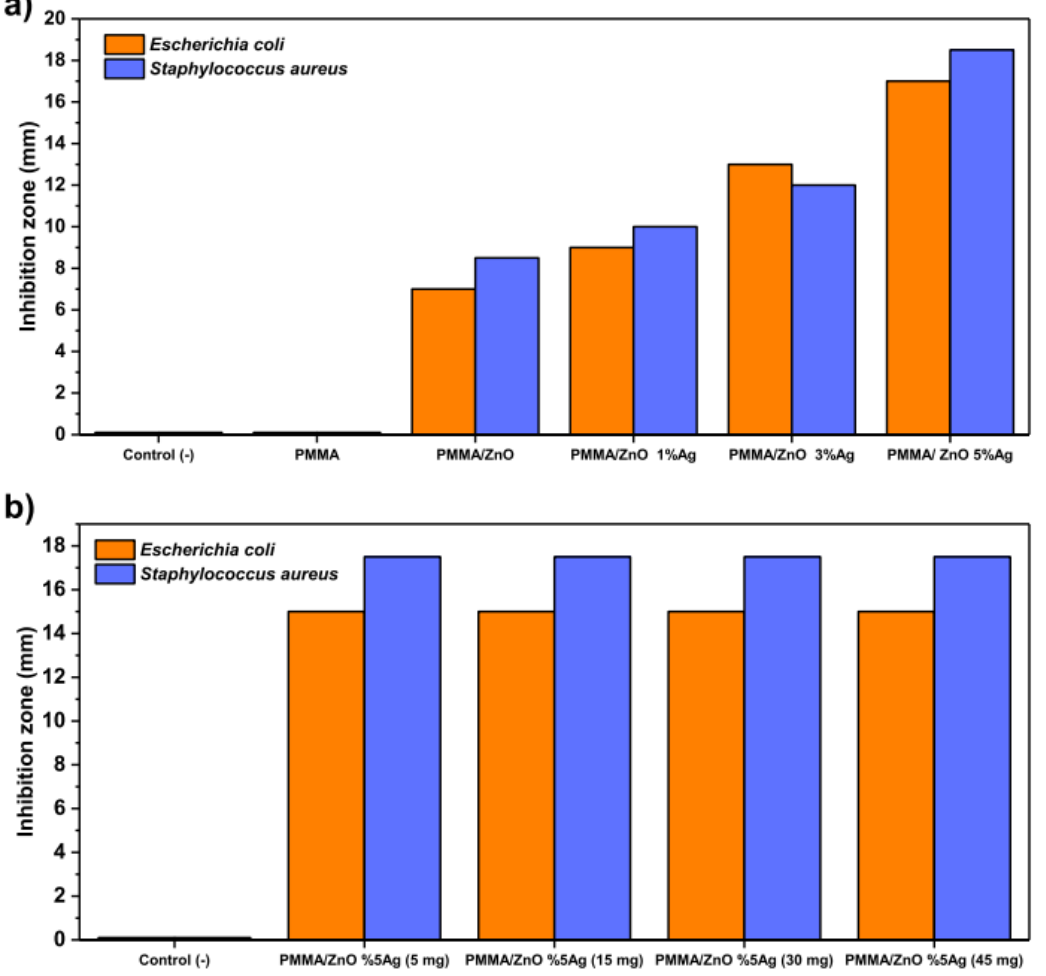
Figure 5. Antibacterial activity of NF mats. ( a ) Antibacterial activity of different types and different Ag concentrations of NF mats. ( b ) Antibacterial activity of different amounts of PMMA/ZnO-5% Ag NF mats [99]. Reprinted with permission from ACS Appl. Mater. Interfaces 2021, 13, 4, 5678–5690. Copyright (2021) American Chemical Society.